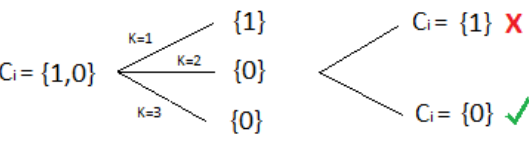
Figure 3: Instance with imprecise output that is relabelled according to their neighbors